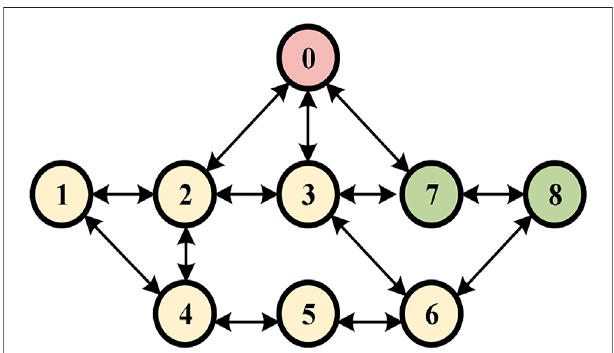
FIGURE 4 | The energy fl ow topology of the low-carbon port microgrid.